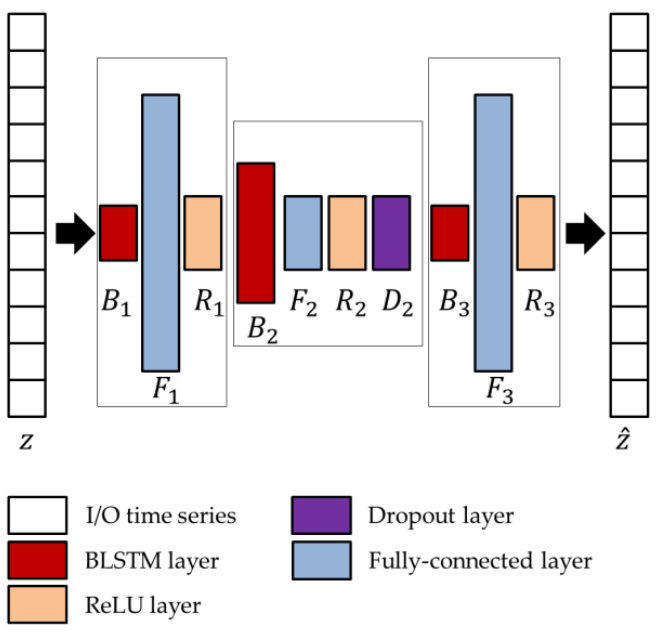
Figure 4. Architecture of the BLSTM-AE network. Figure 4 . Architecture of the BLSTM-AE network. Table 3. Optimized parameters of the network architecture shown in Figure Table 3. Optimized parameters of the network architecture shown in Error! Reference source not found. .